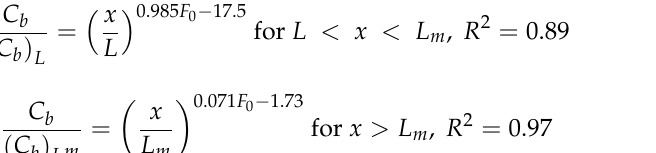
to 6.22 at x / L = 1.91. (2) In contrast, f b h 0 / V 0 decreased slightly in the impact zone, and there was a large variation in air bubble concentration C b . (3) Furthermore, f b h 0 / V 0 increased with increasing F 0 .